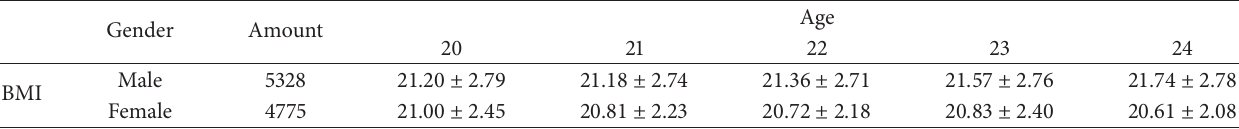
Table 3: BMI of male and female university students at different ages.